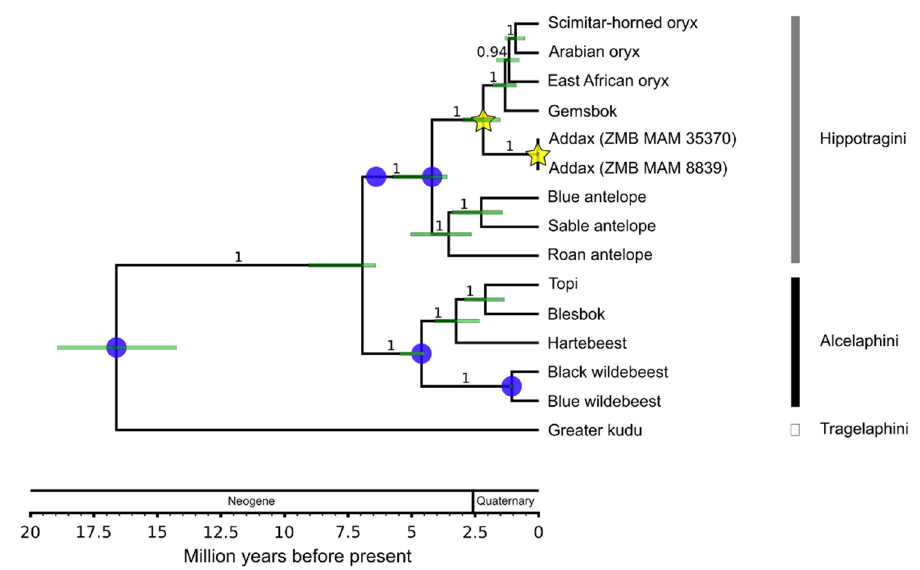
Figure 4. Calibrated mitochondrial species phylogeny. Branch values show Bayesian posterior probabilities, light green node bars represent 95% credibility intervals of divergence time. Blue circles mark the five fossil calibrations used. Yellow stars mark the Addax / Oryx divergence (1.51–2.98 Mya) and the most recent common ancestor of the addax samples (11–58 kya, 95% credibility interval).